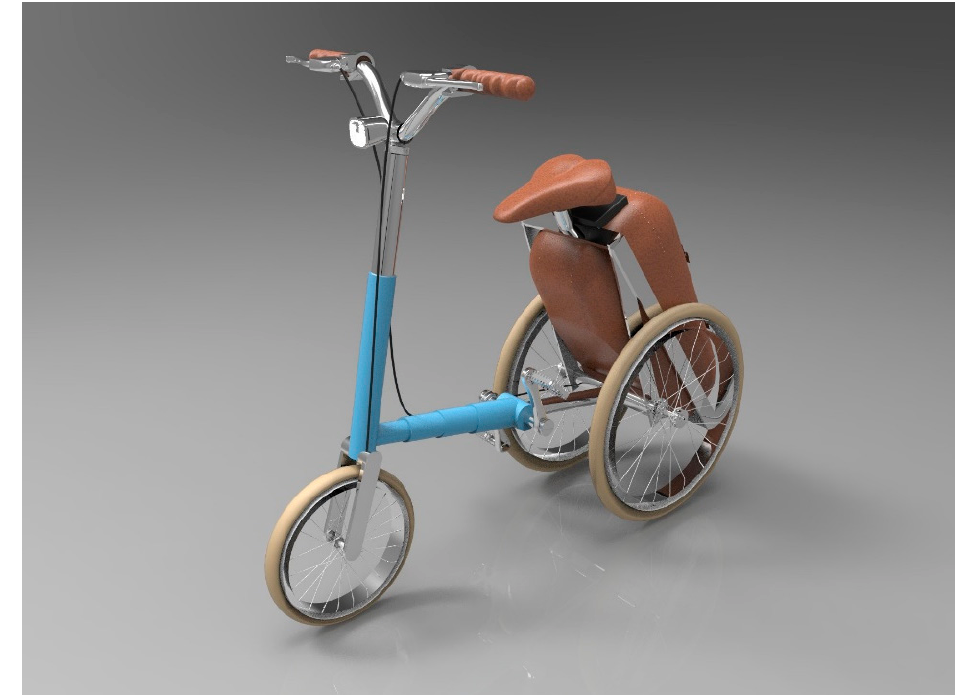
Figure 16. 3D model and rendering.